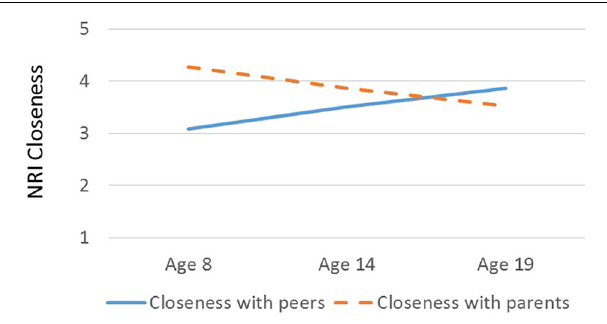
FIGURE 1 | Interaction between age (in years) and closeness scores on the Network of Relationships Inventory. Blue solid line, closeness to peers (same- and opposite-sex friend); orange dashed line, closeness to parents (mother and father). Plotted closeness scores are estimated from marginal means for different relationship types (peers vs. parents) at age 8, age 14, and age 19, with Sex held constant.